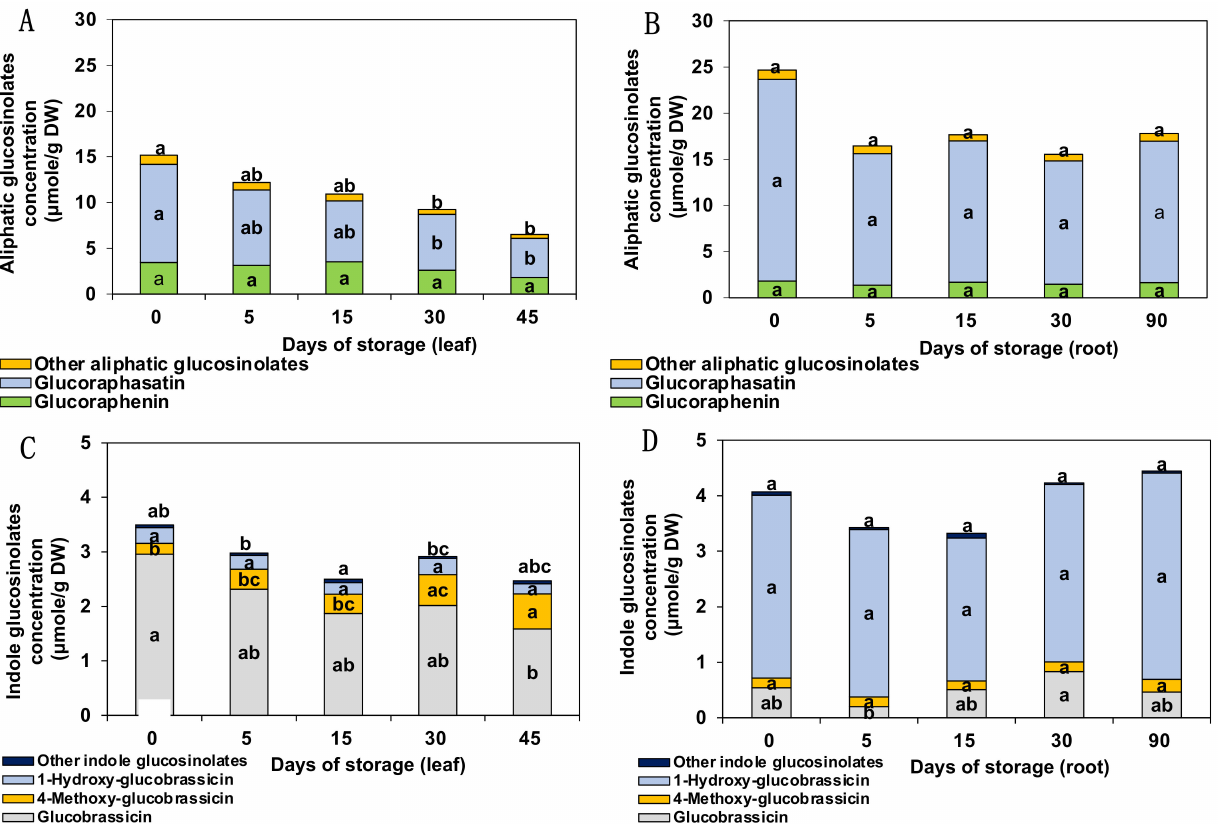
Figure 1. Aliphatic and indole glucosinolate concentration changes in detached leaf ( A , C ) and topped radish root ( B , D ) during 1 ◦ C cold postharvest storage. Mean is expressed as from triplicates (n = 3). Different letters indicate significant difference across different days of storage within the same compound at p = 0.05 by Tukey’s